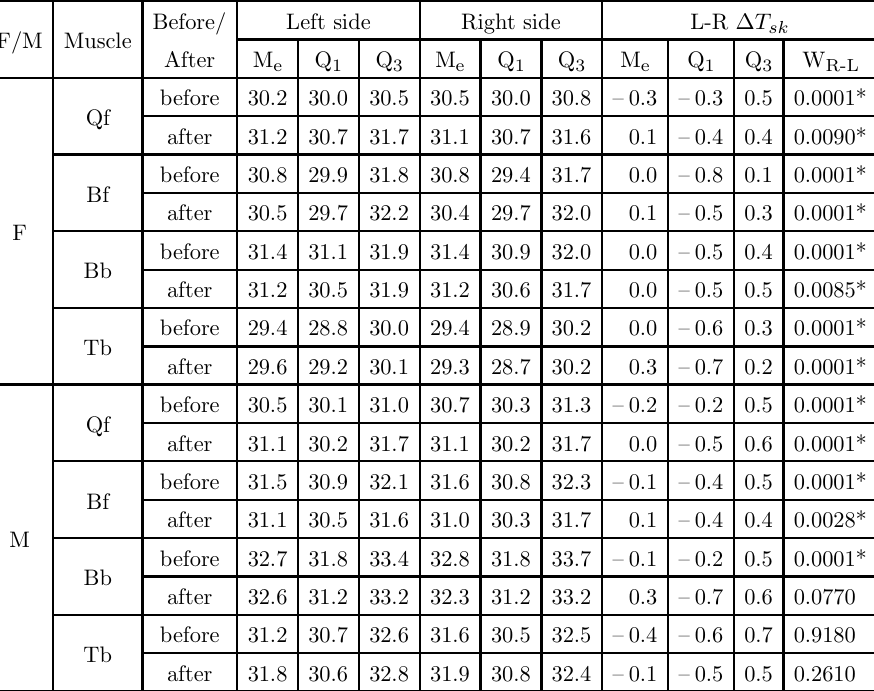
◦ Table 4. Skin temperature ( C) of muscles areas before and after RT Before/ Left